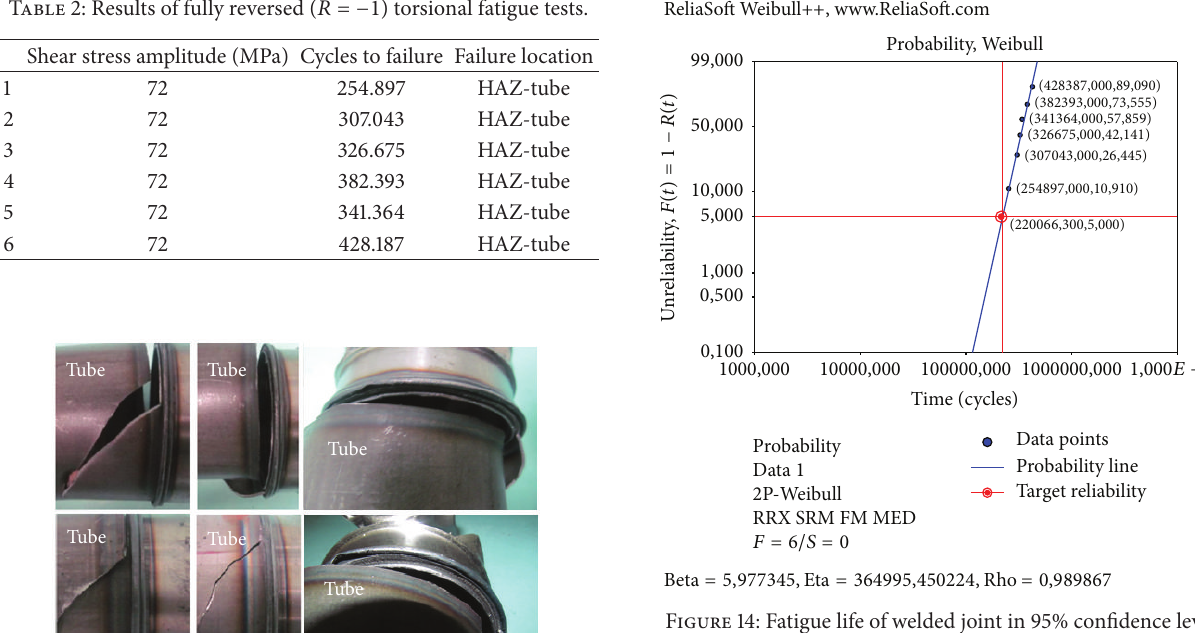
Figure 14: Fatigue life of welded joint in 95% confidence